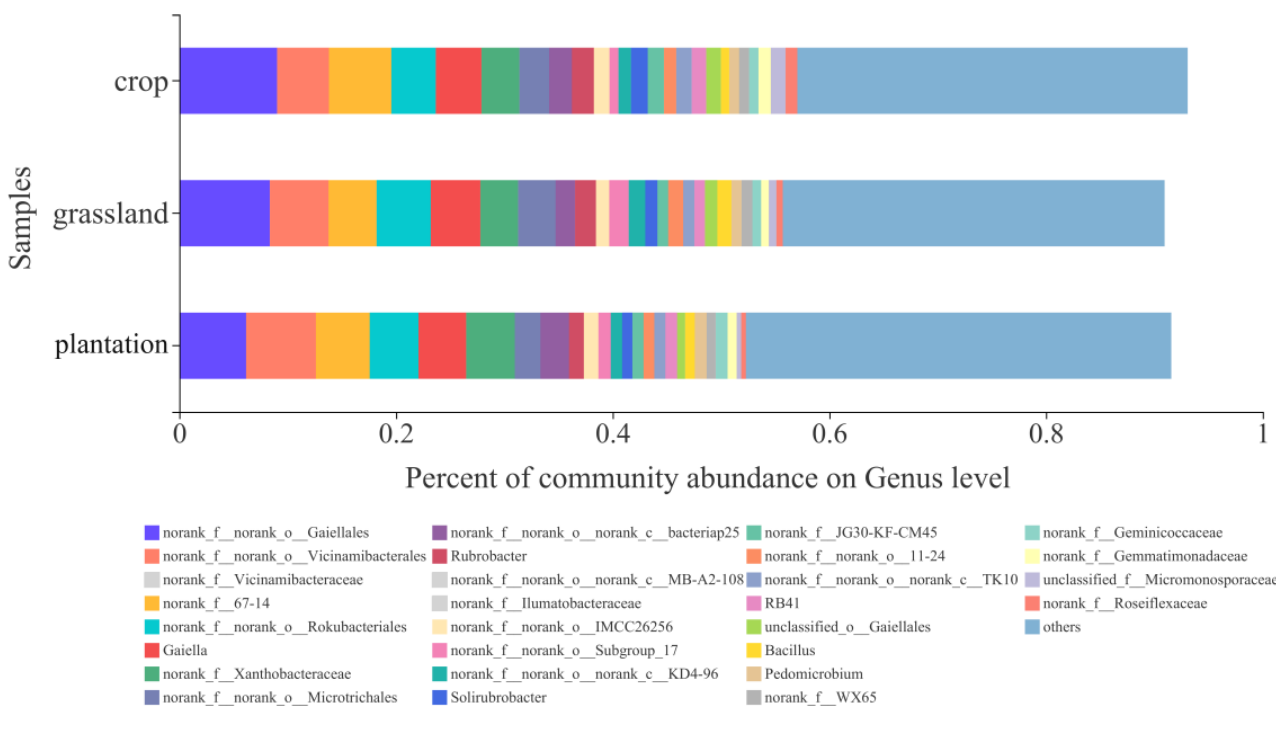
Figure 5. Relative abundance of soil bacteria at genera level in three karst land-use types.